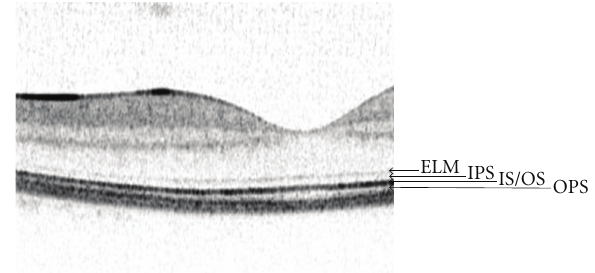
Figure 1: Spectral domain OCT scan of the retinal layers in a normal macula: ELM: external limiting membrane, IPS: inner photoreceptor segments, IS/OS: junction between inner and outer photoreceptor segments, and OPS: outer photoreceptor